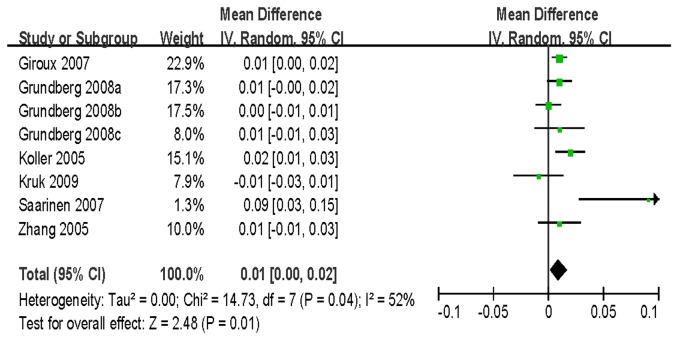
WMD and 95% CI in FN BMD between A1330V AA and AV/VV genotypes.